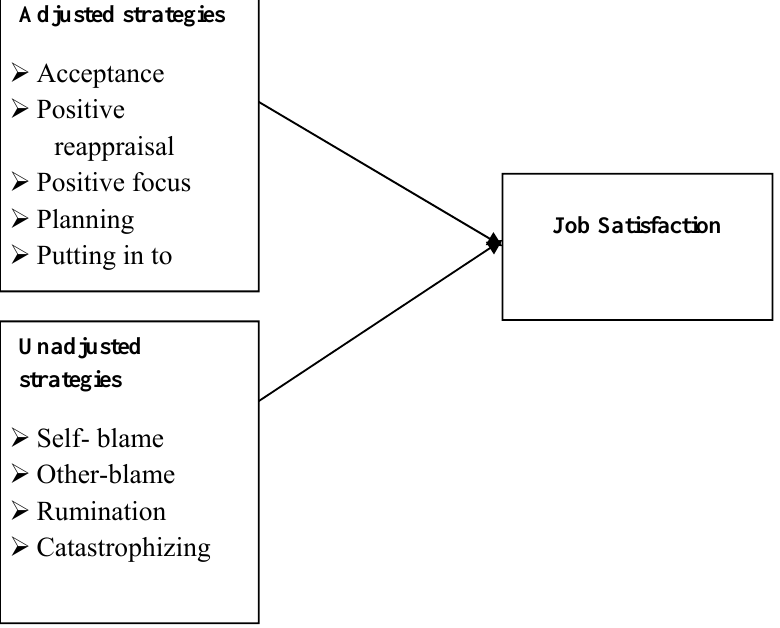
Fig. 1. The conceptual research